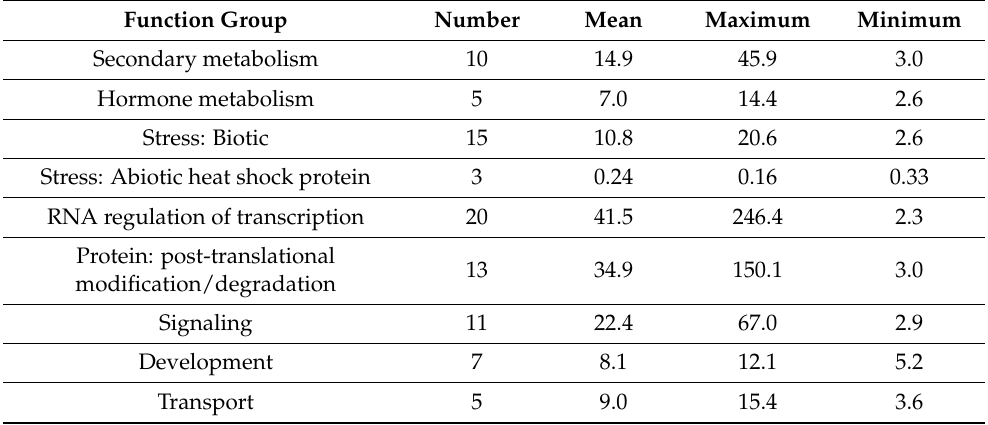
Table 3. Number, mean value, maximum, and minimum fold change of the transcript abundance of major functional groups of annotated DEGs affected by HF infestation in heat-stressed